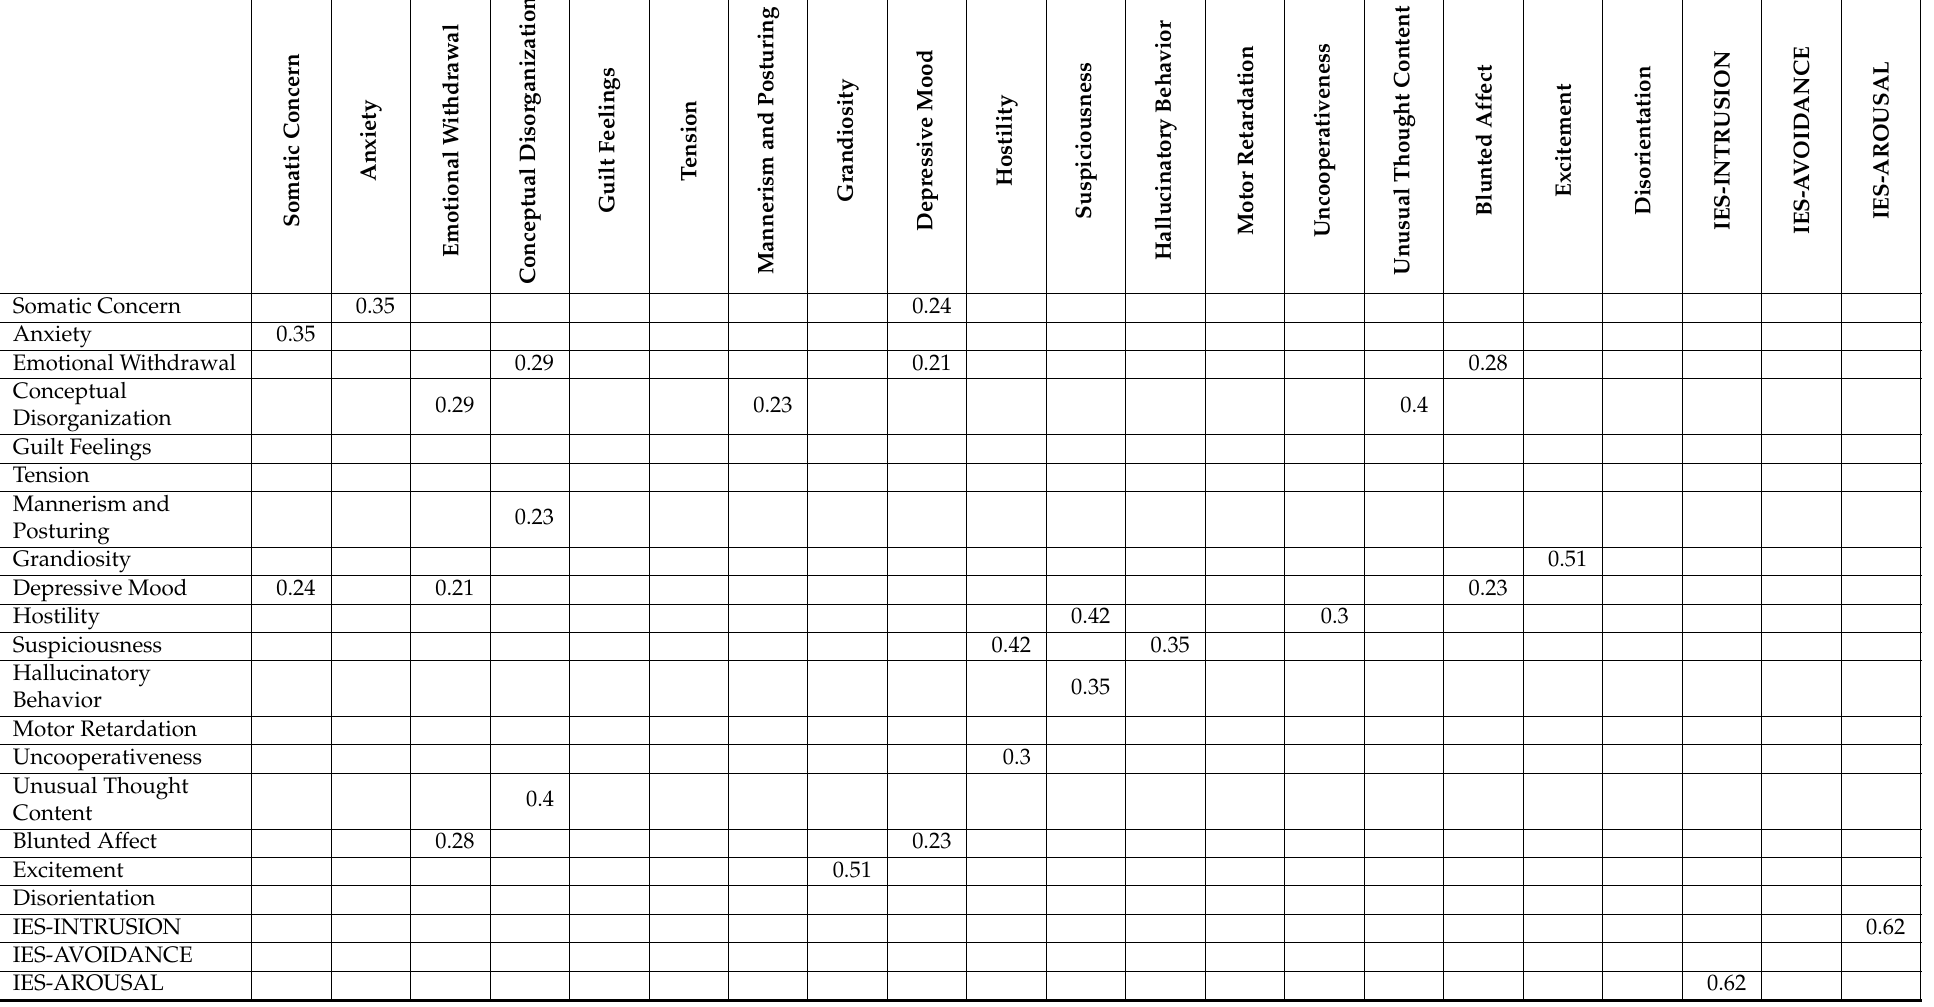
Table 4. Weighted adjacency matrix of the November